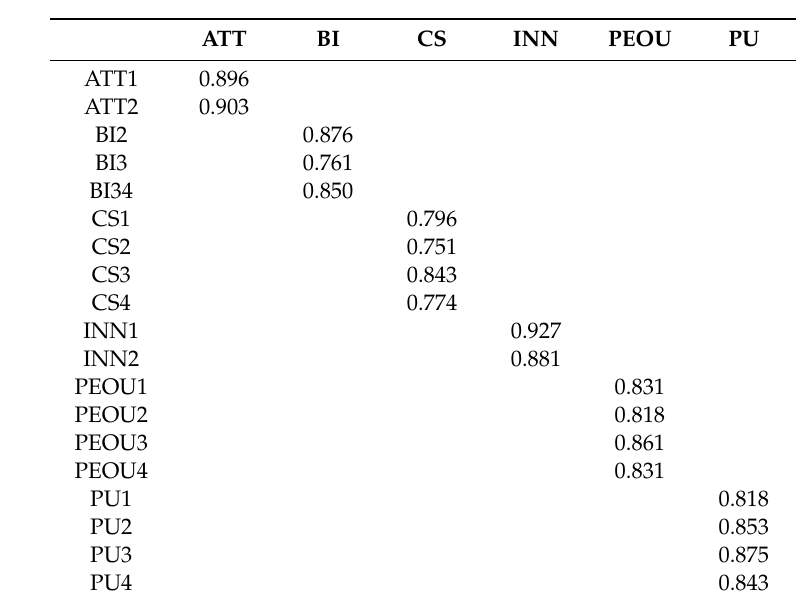
Table 6. Outer loadings.